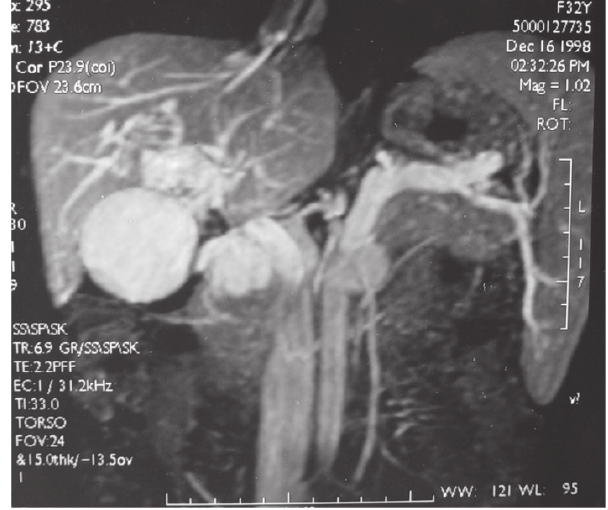
Figure 2 - Nuclear magnetic resonance, in a sagittal cut, showing the dilated portal vein with the maximum diameter being the same as that revealed by computed tomography. Performed in